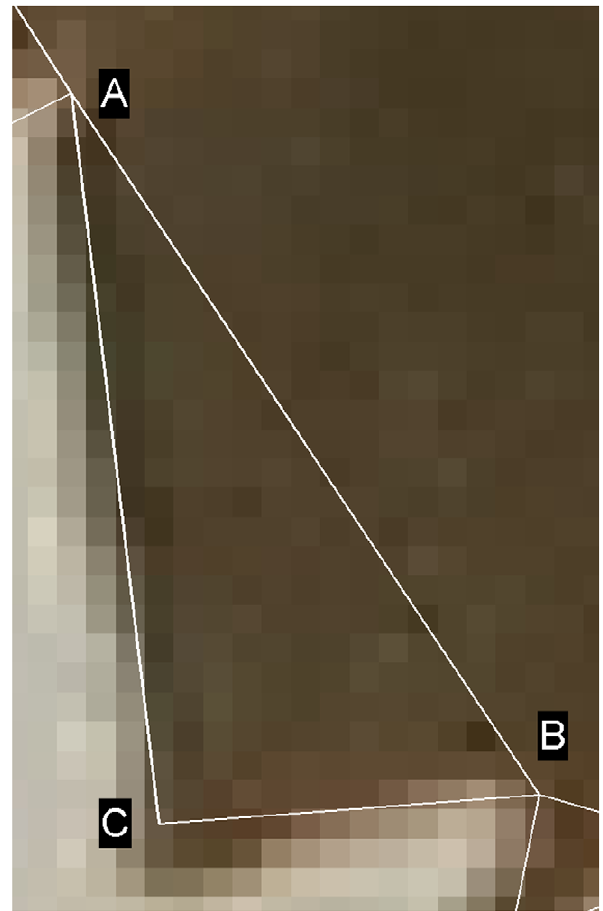
Figure 4. A single tooth modeled as a triangle. The visible pixelation is due to this being a small detail from a much larger